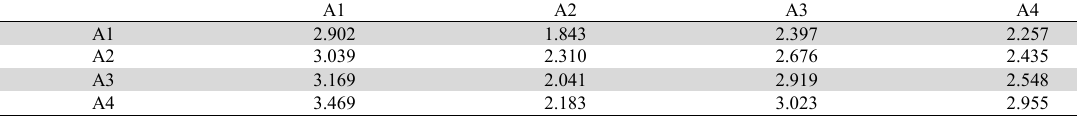
Total interrelationship matrix of attributes